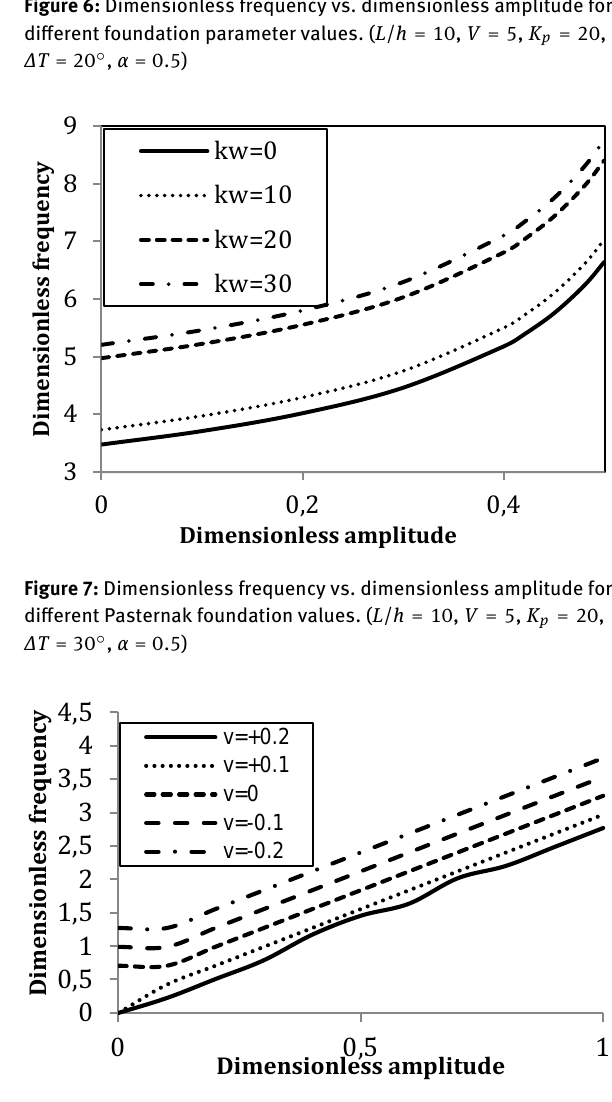
Figure 8: Dimensionless frequency vs. dimensionless amplitude for different electric voltages. ( L / h = 10 , K w = K p = 20 , ∆T = 20 ∘ , α = 0.5